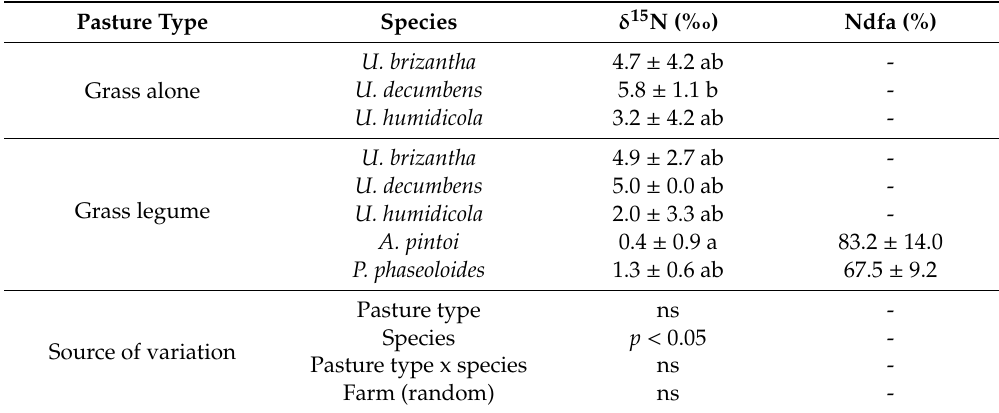
Di ff erent letters indicate statistical di ff erences according to the TukeyHSD test ( α = Different letters indicate statistical differences according to the TukeyHSD test ( α = 0.05).